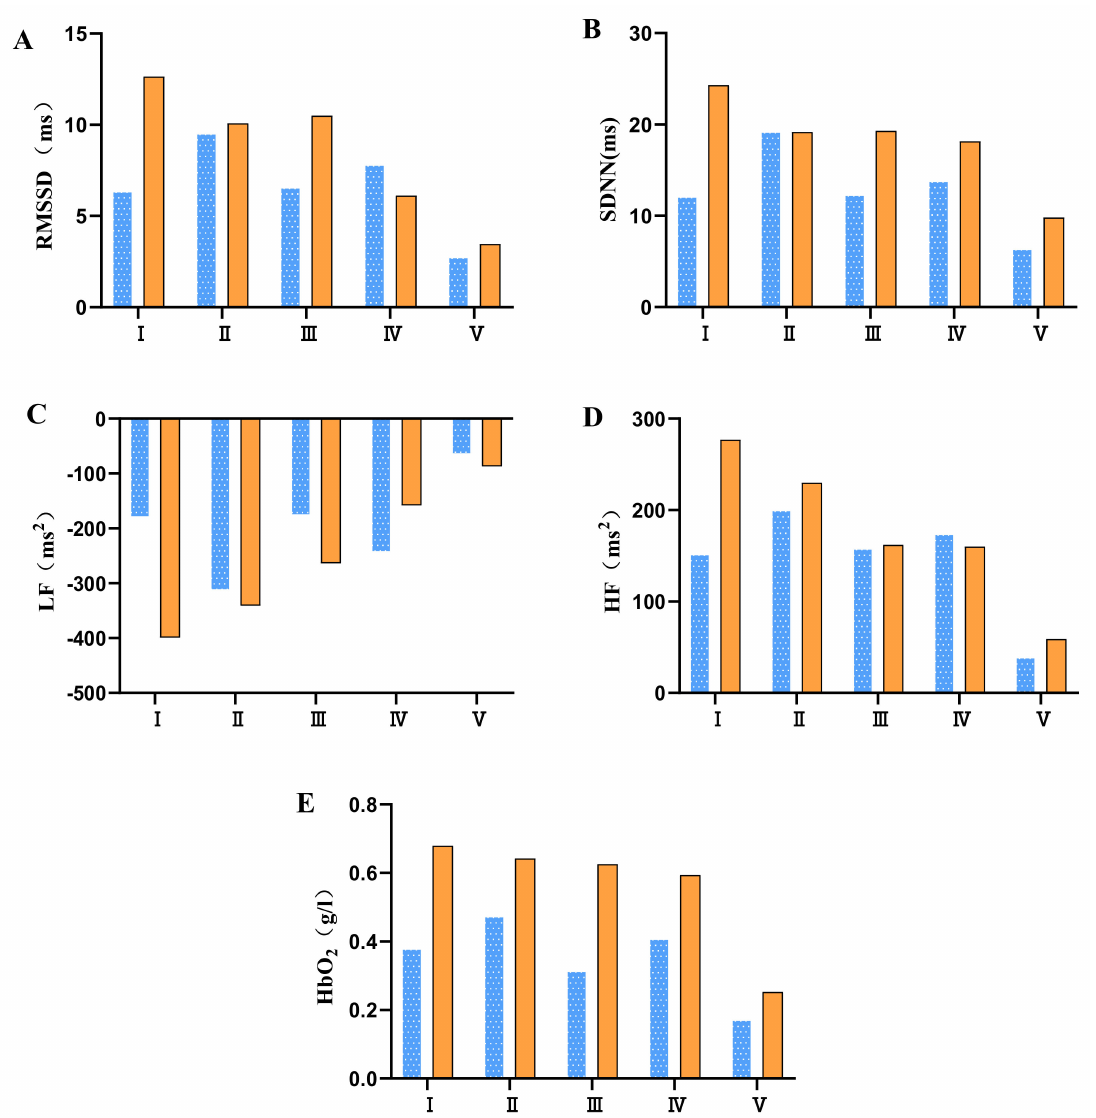
Figure 3. Comparison of the effects of tPCS intervention programs on the indicators of HRV and HbO 2 after physical fatigue. Note: means moderate physical fatigue; means severe physical fa- tigue. ( A ) Difference of different tPCS intervention programs on RMSSD before and after intervention. ( B ) Difference of different tPCS intervention programs on SDNN before and after intervention. ( C ) Difference of different tPCS intervention programs on LF before and after intervention. ( D ) Difference of different tPCS intervention programs on HF before and after intervention. ( E ) Difference of different tPCS intervention programs on HbO 2 before and after